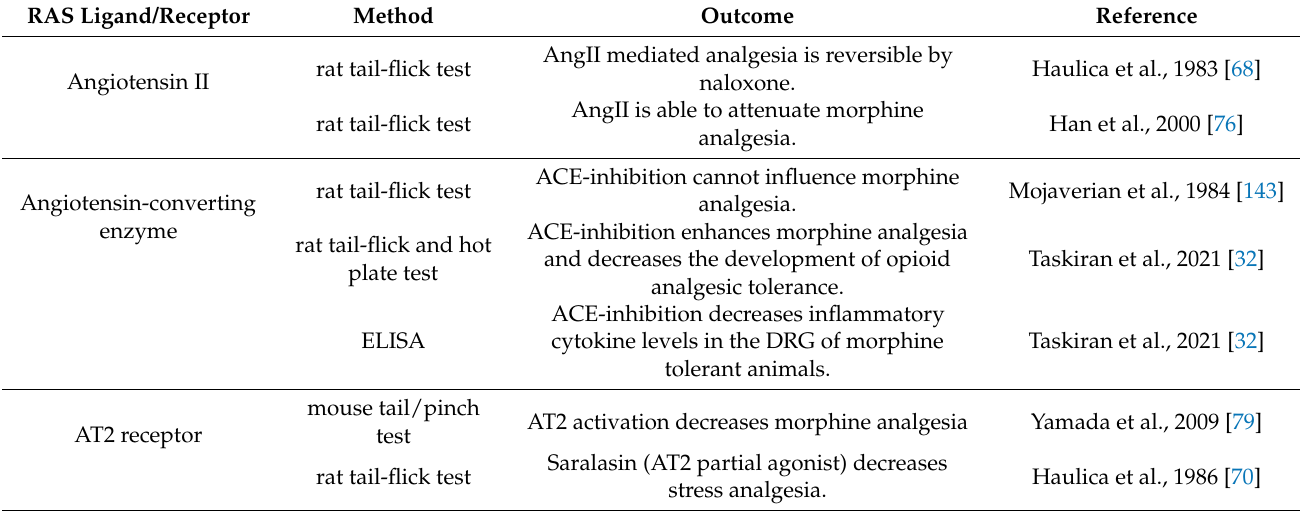
Table 2. Reported connections between the opioid and renin–angiotensin systems in relation to pain. RAS Ligand/Receptor